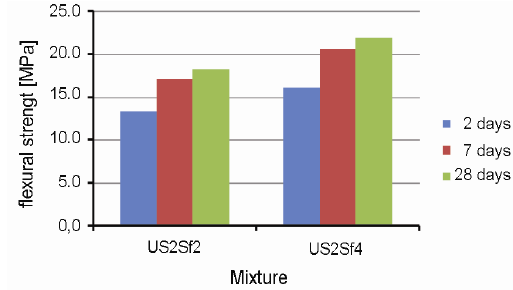
Fig. 5. Flexural strength test results on samples of